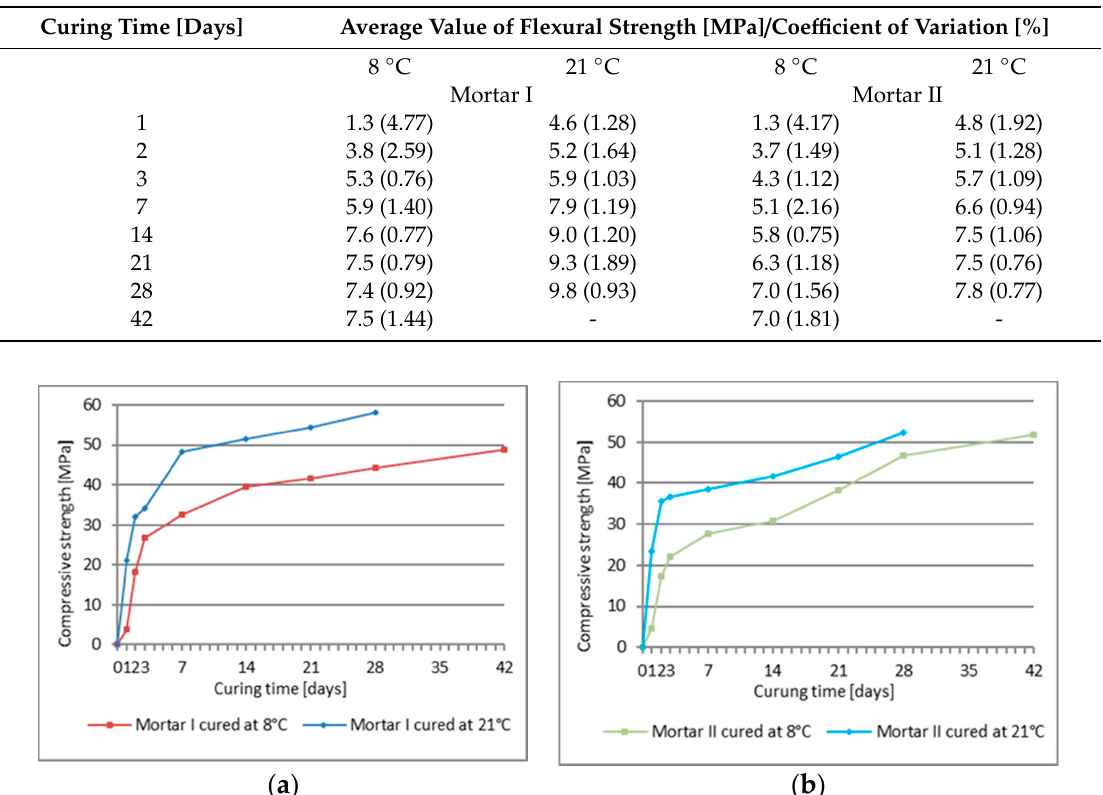
Figure 3. Compressive strength of mortars cured at 8 °C and 21 °C, following subsequent curing periods (average value): ( a ) PCC mortar I, ( b ) PCC mortar II.